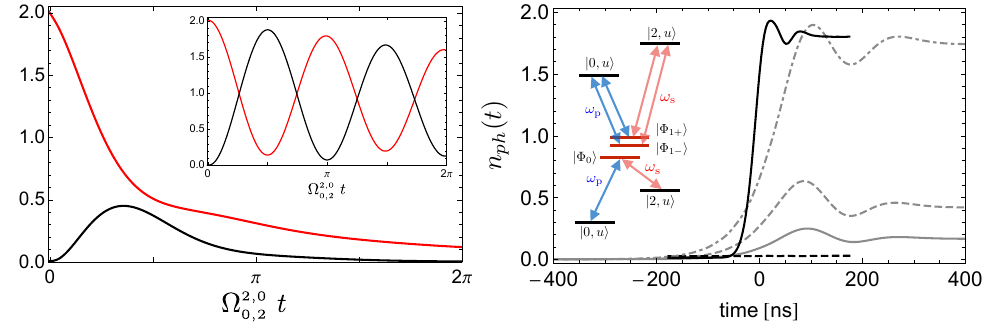
011031-5 FIG. 6. Dynamics starting from a mechanical Fock state. The ˆ B † ˆ B , while blue dashed curves describe the mechanical signal i h ˆ A † ˆ A the black solid curves describe the optical signal . The h i green curves correspond to the negativity N . The cavity fre- 011031-5 quencyisinitiallydetunedfromtheDCEresonance( δω c 0 . 1 ), ¼ and the system is initially prepared in the state 0 ; 2 . Then the j i cavity is quickly tuned to the DCE resonance ( δω c → 0 ). The initial detuning δω c is displayed as a small red solid curve in Figure 2. Left panel. Evolution of phonons (red curves) and photons (black curves) for an the lower left-hand corner of both panels, near t 0 . In (a), the FIG. 6. Dynamics starting from a mechanical Fock state. The ¼ dynamics is evaluated in the weak-coupling regime. Panel optomechanical system prepared in the mechanical Fock state 0,2 , for matching energy splitting, ˆ B † ˆ B (b) displays the vacuum Casimir-Rabi oscillations that arise , while blue dashed curves describe the mechanical signal | (cid:105) when the system loss rates are low. The parameters used are i h Ω 2,0 ˆ A † ˆ A ω c ω m , in the weak-coupling regime with an oscillator loss rate γ = 0.2 , and a cavity loss rate provided in the text. the black solid curves describe the optical signal . The 0,2 (cid:39) × h i green curves correspond to the negativity N . The cavity fre- κ = 2.5 γ . Here Ω 2,0 the energy splitting of levels 0,2 and 2,0 calculated for G / ω m = 0.1. The inset 0,2 | (cid:105) | (cid:105) curve)calculatedfor g / ω m 0.1.Figure6alsodisplaysthe quency is initially detuned from the DCE resonance ( δω 0 . 1 ), ¼ c ¼ initialdetuning δω c (redsolidcurve).Figure6(a),obtained shows the same dynamics for γ = κ = Ω 2,0 /80, while the coherent exchange of excitations is almost 0,2 and the system is initially prepared in the state 0 ; 2 . Then the 2 ; 0 using γ 0 ; 2 /5 and κ ¼ 2 . 5 γ , describes the irreversible ¼ Ω complete. Right panel. Average photon number n ph ( t ) of STIRAP protocol for Vee (black curves) j i mechanical decaydueto bothnonradiative(inducedbythe cavity is quickly tuned to the DCE resonance ( δω 0 ). The c → and Λ (gray curves) scheme. Thick curve represents n ph ( t ) for the Rabi Hamiltonian including the initial detuning δω is displayed as a small red solid curve in c light emission (black solid curve), and to transient mirror- stray couplings, while dashed lines refer to the case where only the stray RWA coupling is present. the lower left-hand corner of both panels, near t 0 . In (a), the field entanglement. Figure 6(b), obtained using the lower ¼ dynamics is evaluated in the weak-coupling regime. Panel The dot dashed gray line refers to the Λ scheme in the absence of stray couplings. The level schemes for (b) displays the vacuum Casimir-Rabi oscillations that arise STIRAP are shown in the inset: the Stokes (frequency ω s , red arrows) and the pump ( ω p , blue arrows) when the system loss rates are low. The parameters used are nu fields couple factorized eigenstates of H R with selected dressed eigentates. In the Λ scheme they provided in the text. | (cid:105) Φ are coupled to the dressed ground state 0 (cid:105) (lower energy levels) while ìn the Vee scheme with the | Φ excited states (larger energy 1 | ± (cid:105)